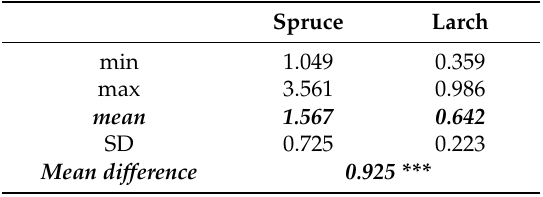
Table 8. The ratios between the proportions by growth and the proportions by area.